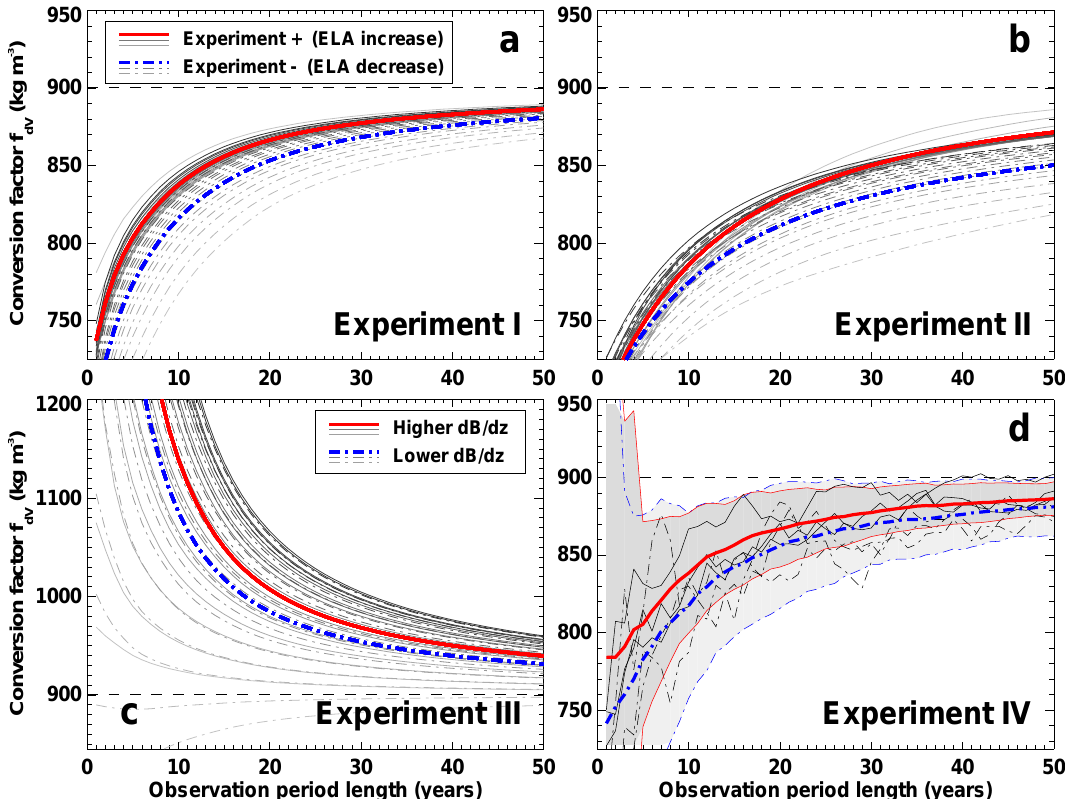
Fig. 4. Calculated conversion factor f 1V for observation period lengths increasing from 1 to 50yr after a change in mass balance (Fig. 3). Thin grey lines refer to model runs using different glacier size (elevation ranges 300–2000m), solid lines show the mean of all experiment simulations for a positive/negative shift in the ELA. In (d) the variability of 200 model runs is expressed as their average ± 2 standard deviations (shaded areas). Selected series of f 1V for individual model runs are